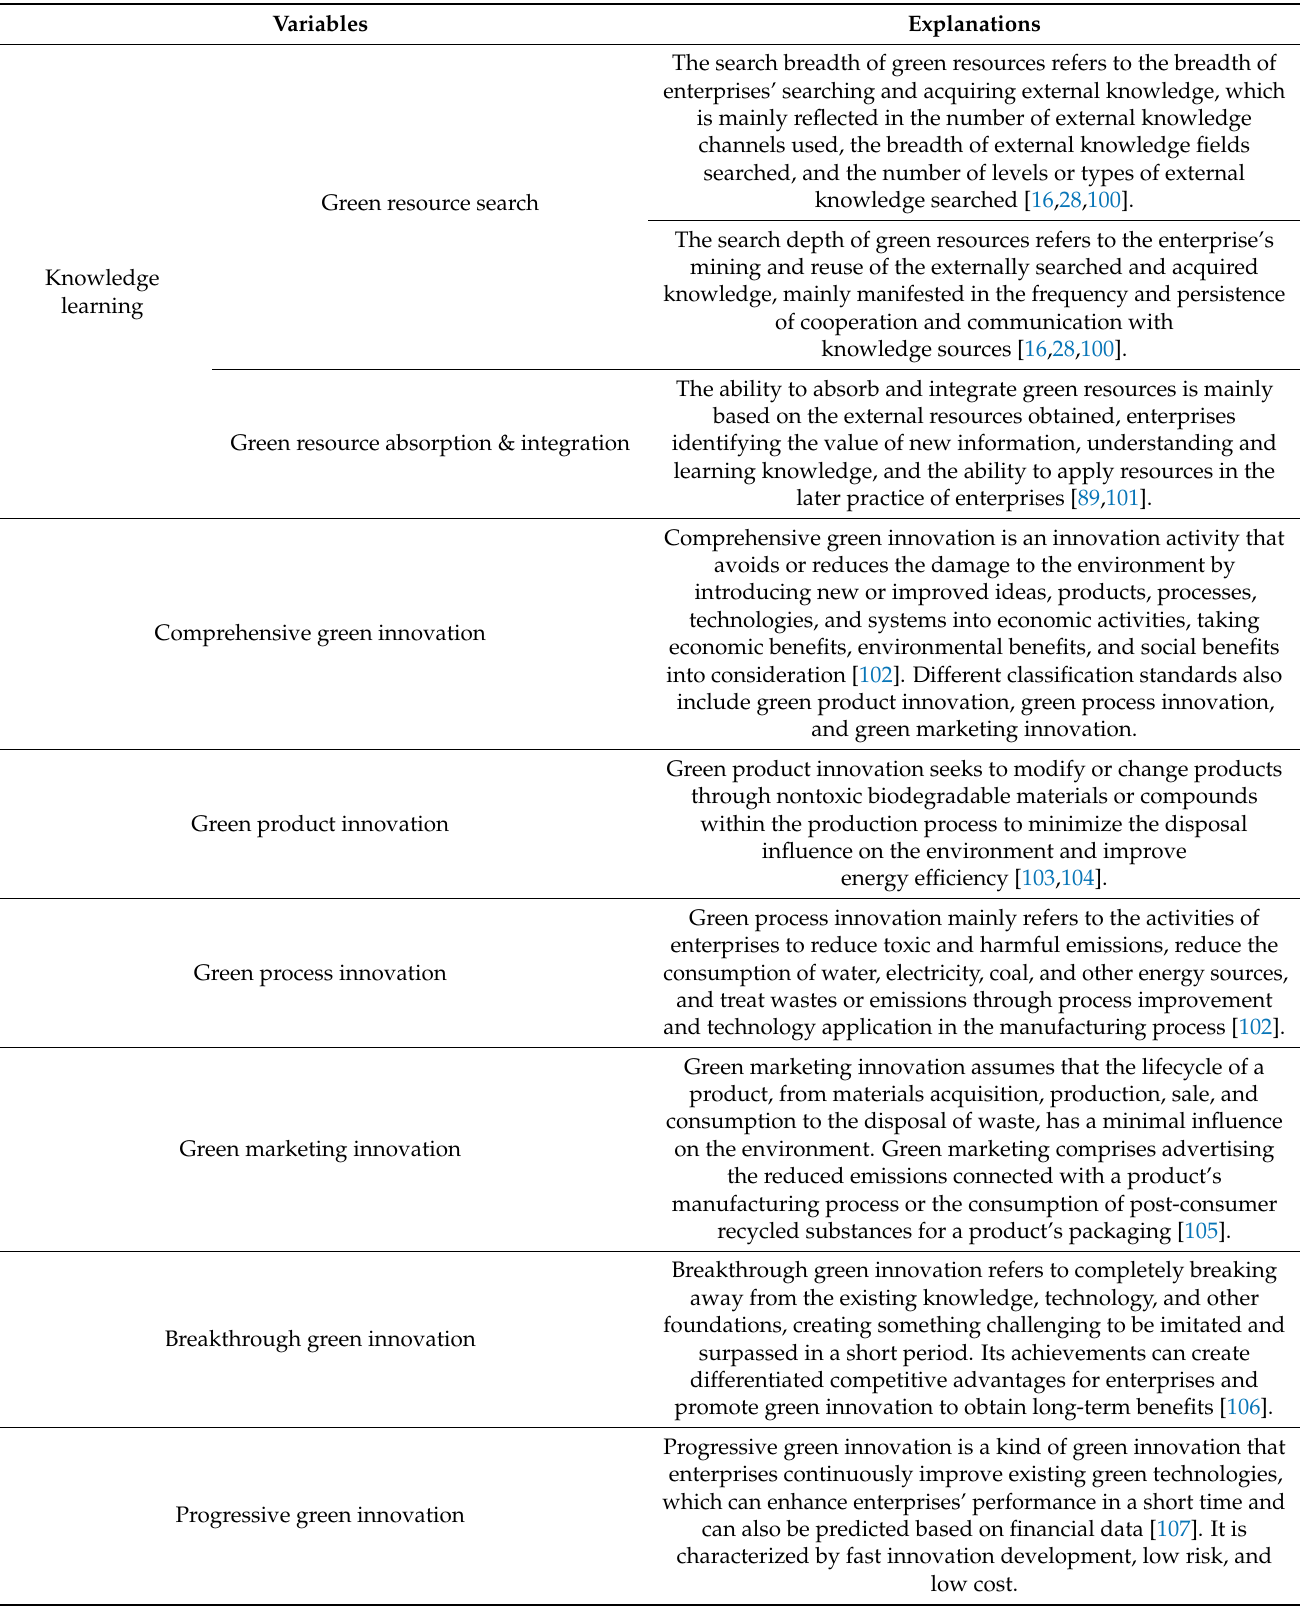
Table 1. Summary of the Main Variable and